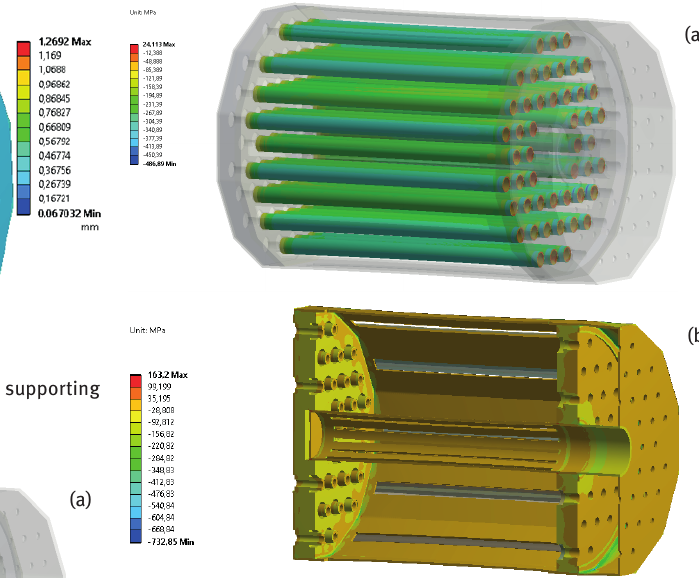
Figure 28: Distribution of operating minimum principal stress of the mSOFC stack with supporting structure: (a) fuel cell view, (b) structure